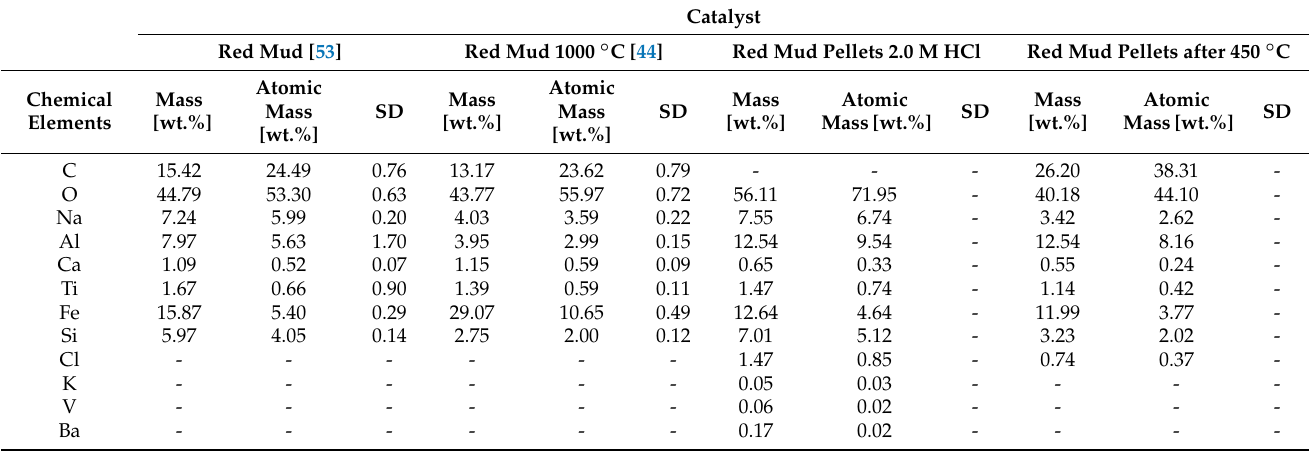
Table 2. Percentages in mass and atomic mass of raw red mud, red mud activated at 1000 ◦ C, red mud pellets activated with 1.0 M HCl after calcination at 500 ◦ C and 4 h, and red mud pellets activated with 1.0 M HCl after upgrading